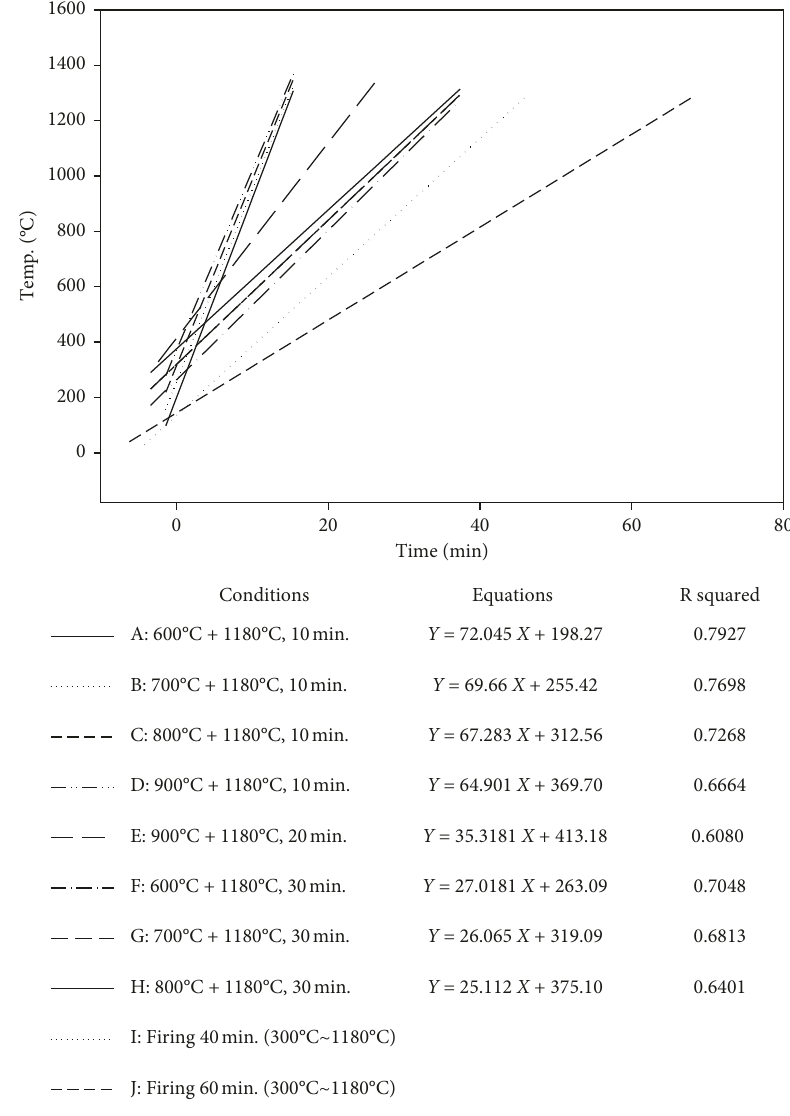
Figure 10: Heating rate graph with various firing